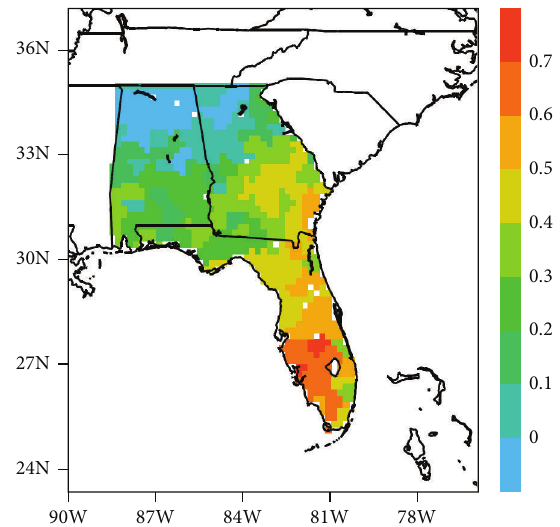
Figure 1: Temporal correlation between November Ni˜no 3 index and the observed rainfall (DJF mean) for 1970–2010: a correlation with the absolute value greater than 0.3 is statistically significant at the 95% confidence